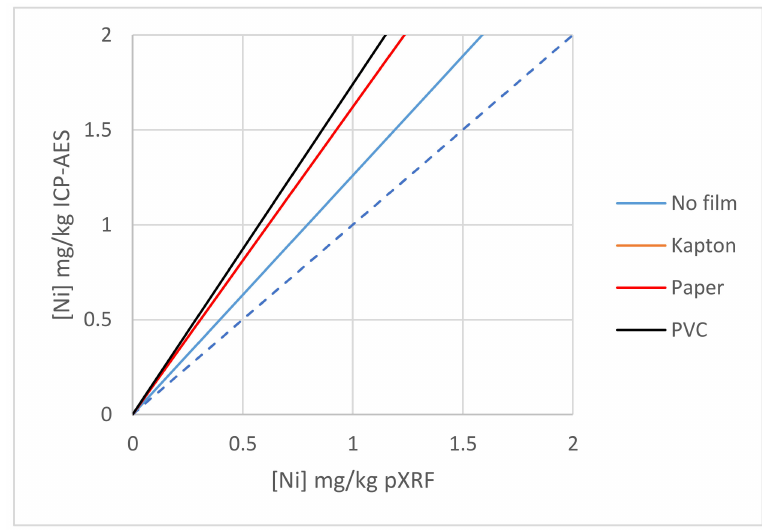
Figure 10. Ni concentrations when measured with a Niton XL3t980 through different membranes, compared to the laboratory